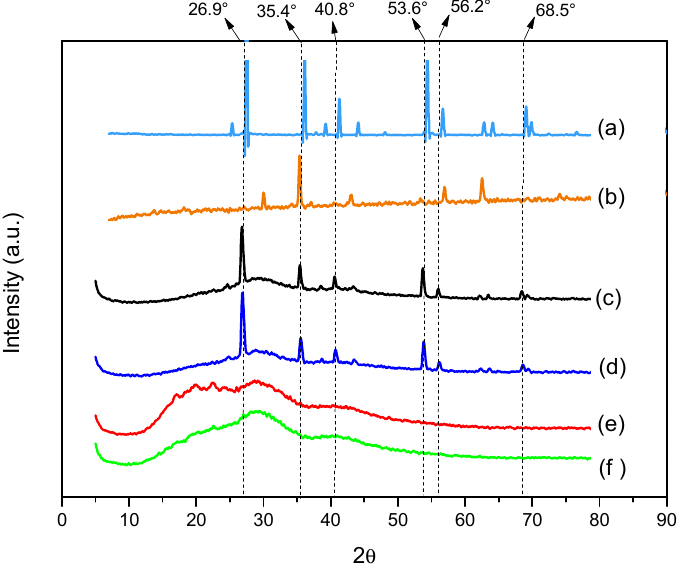
Figure 8. X-ray diffractograms of powder samples of ( a ) TiO—R and ( b ) Fe 3 O 4 and polymeric fibers of PBAT/PLA ( c ) with 10% TiO 2 —R + 1% Fe 3 O 4 ; ( d ) with 10% TiO 2 —R; ( e ) with 1% Fe 3 O 4 ; and ( f ) fiber in the absence of semiconductor.